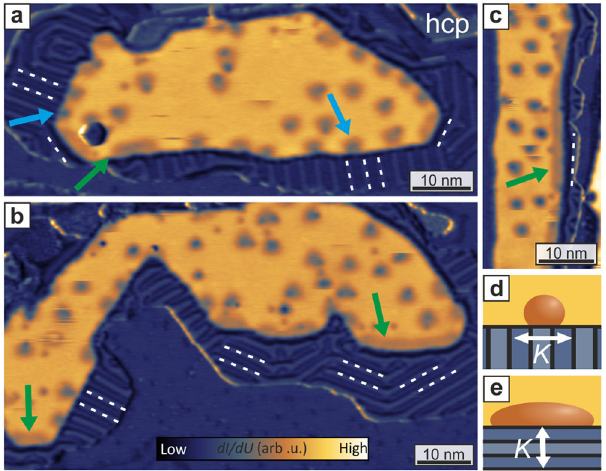
Table 1 Spin dynamics simulation parameters. pseudomorphic (ps) Co/Fe transition area, and the reconstructed (re) Co/Fe.